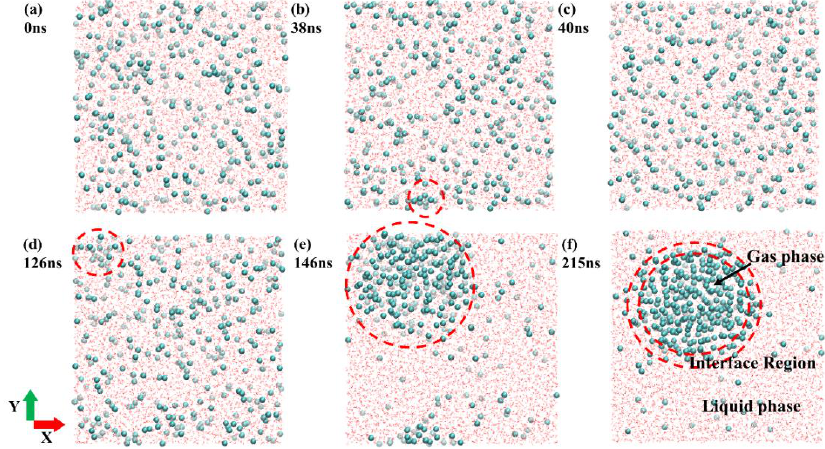
Figure 1. Snapshots of Sys3_5MPa at ( a ) 0, ( b ) 38, ( c ) 40, ( d ) 126, ( e ) 146, and ( f ) 215 ns. Methane molecules and water molecules are represented by cyan balls and red lines, respectively.